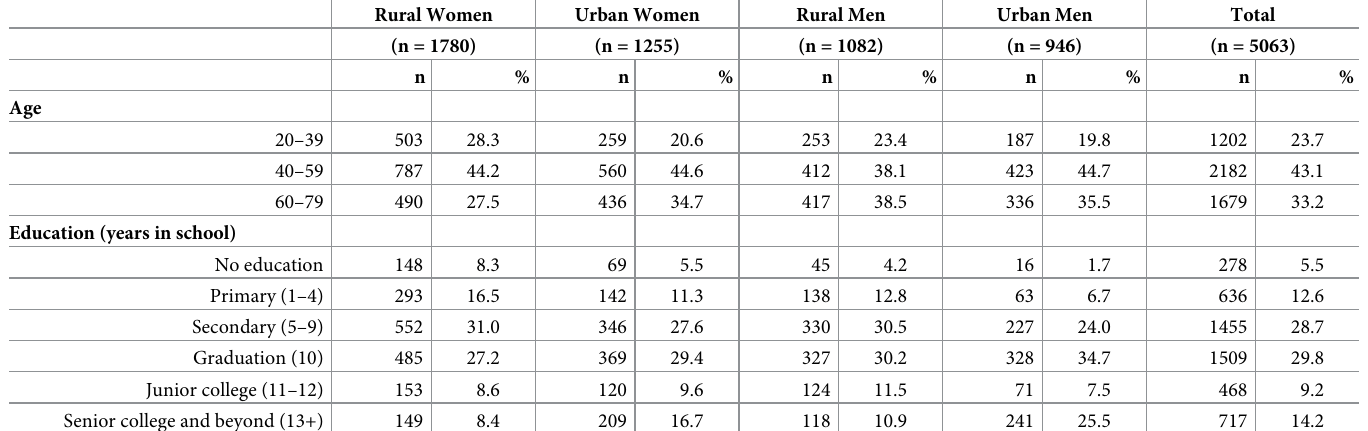
Table 2. Participant age and education status stratified by sex and geographic location.